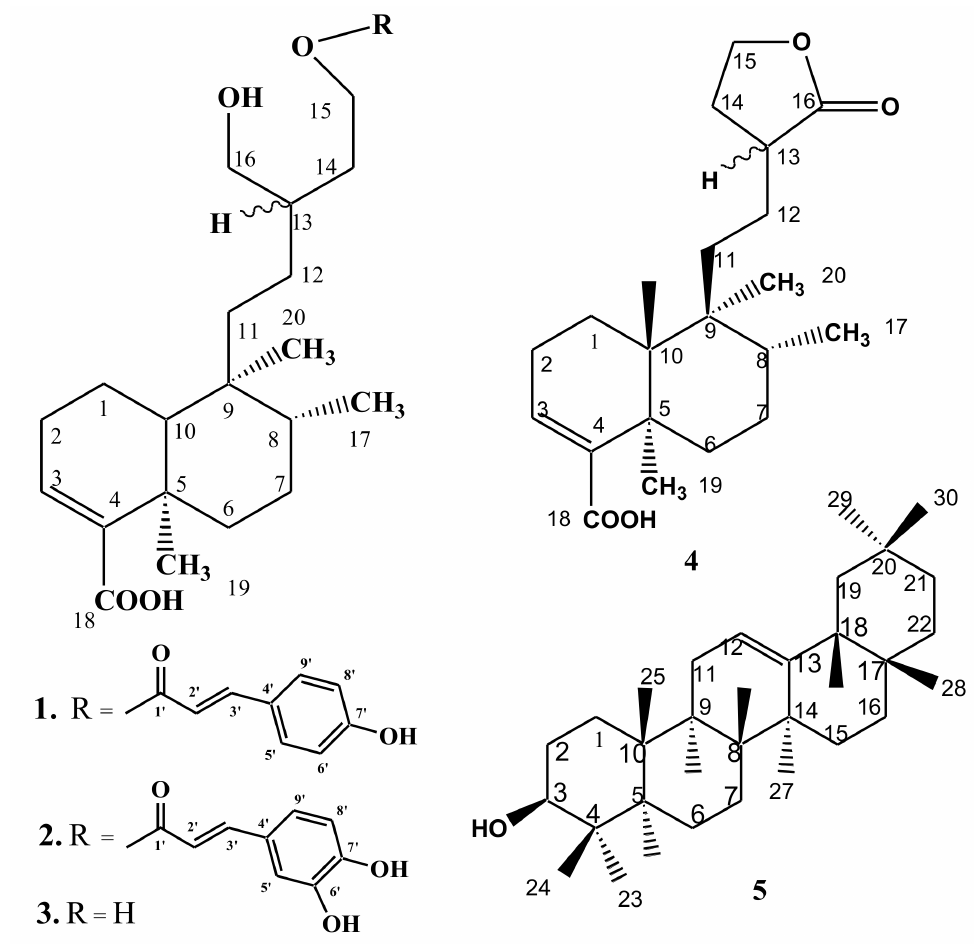
Figure 1. Structures of Compounds 1 – 5